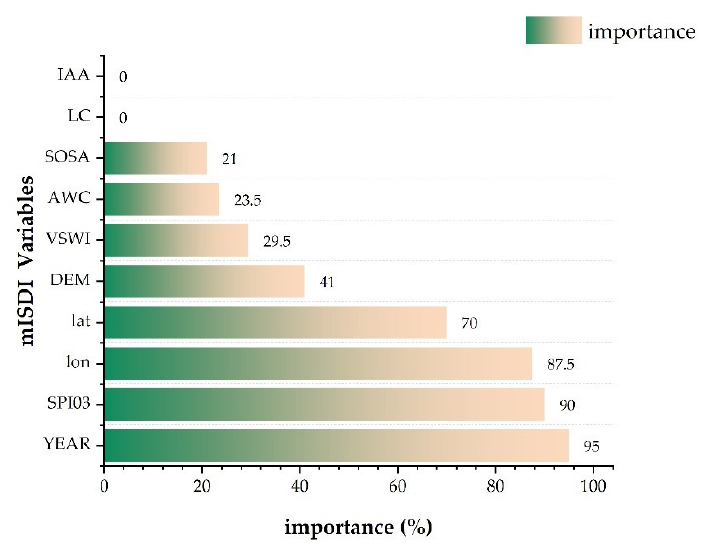
Figure 4. mISDI variables importance.